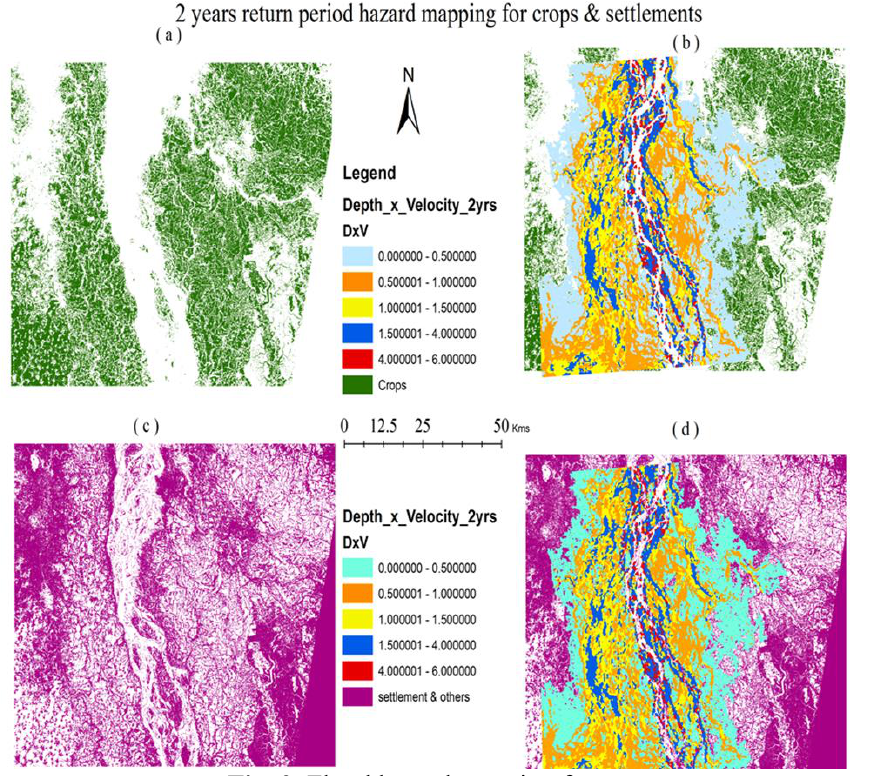
Fig. 9. Flood hazard mapping for